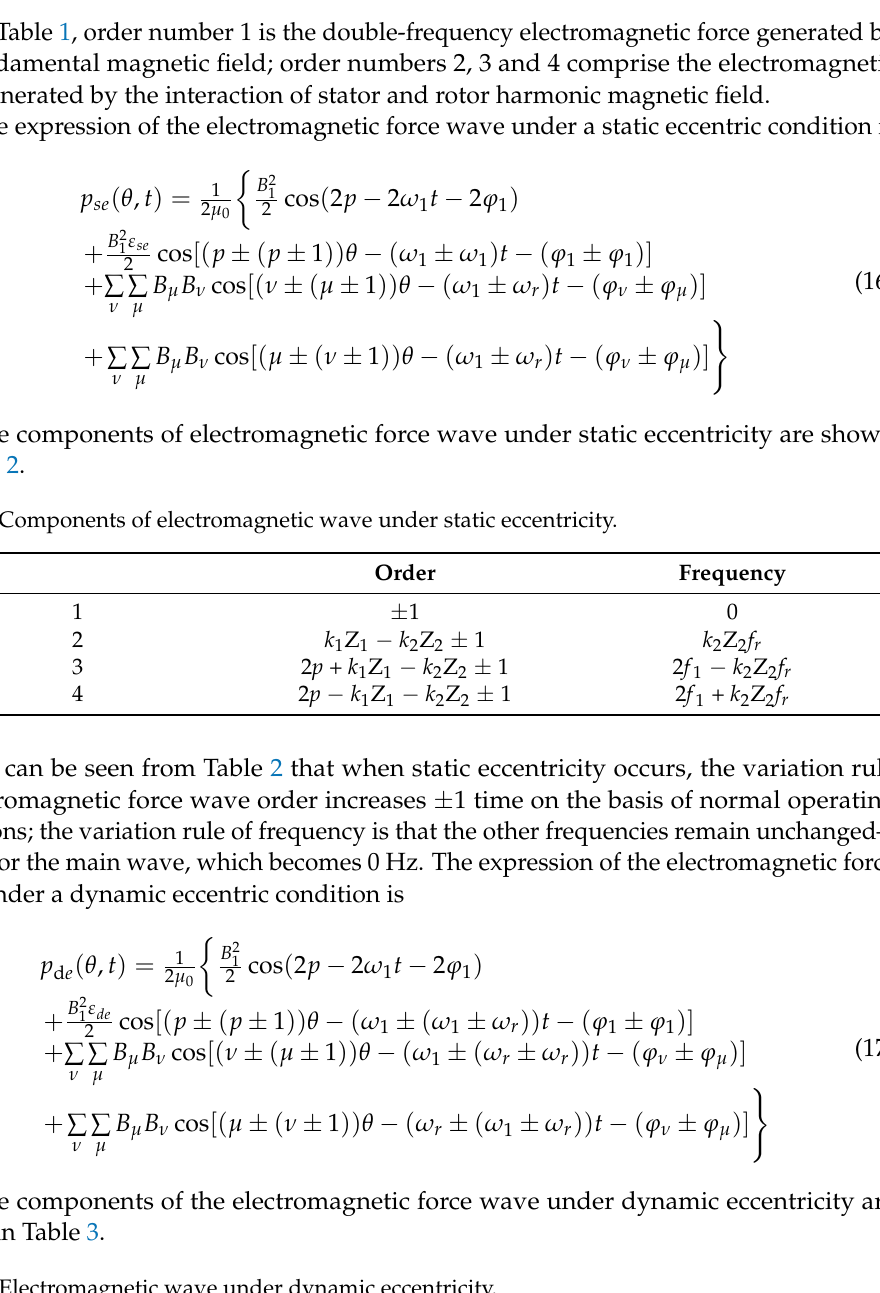
Table 3. Electromagnetic wave under dynamic